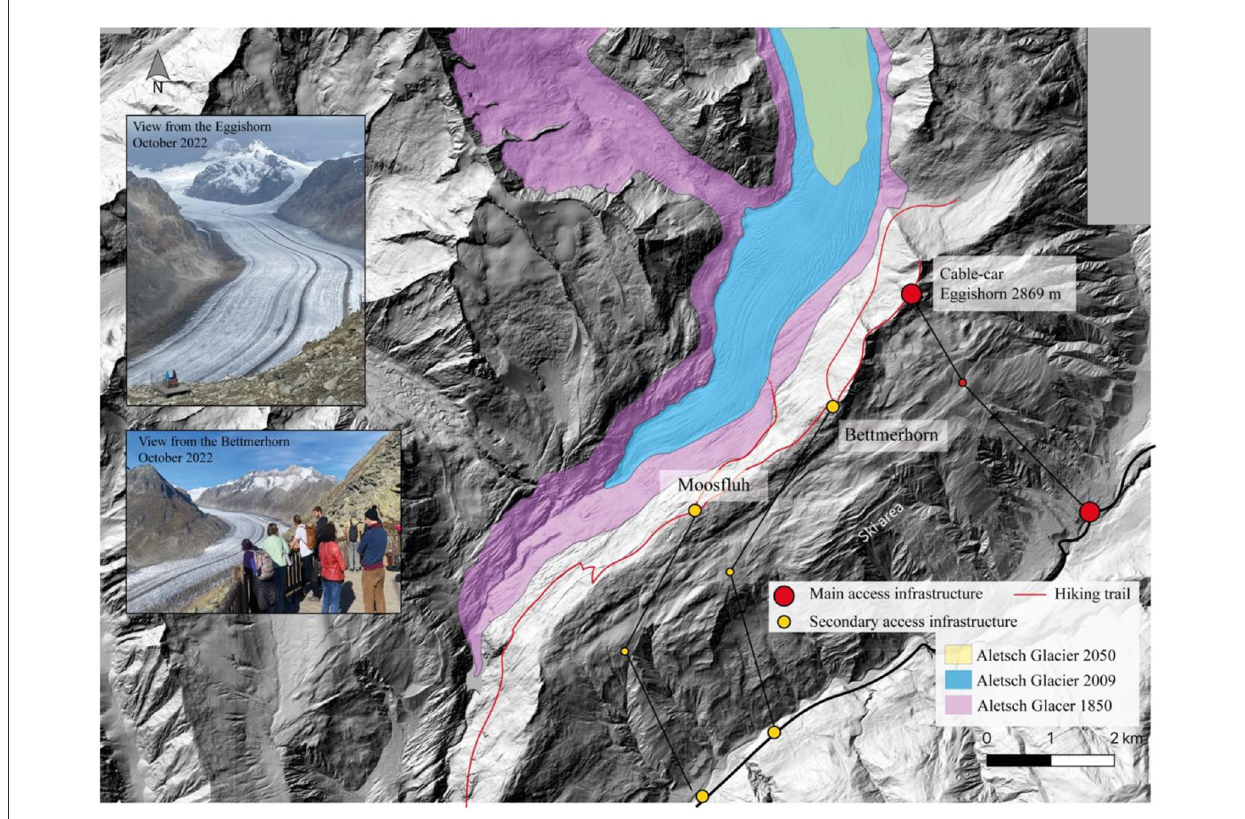
FIGURE1 Map of the tourist site of the Aletsch Glacier. The glacier extensions for 1850 and 2009 are based on GLAMOS-Glacier Monitoring Switzerland (2019) and the 2050 Projection on Jouvet and Huss (2019). Pictures are from the